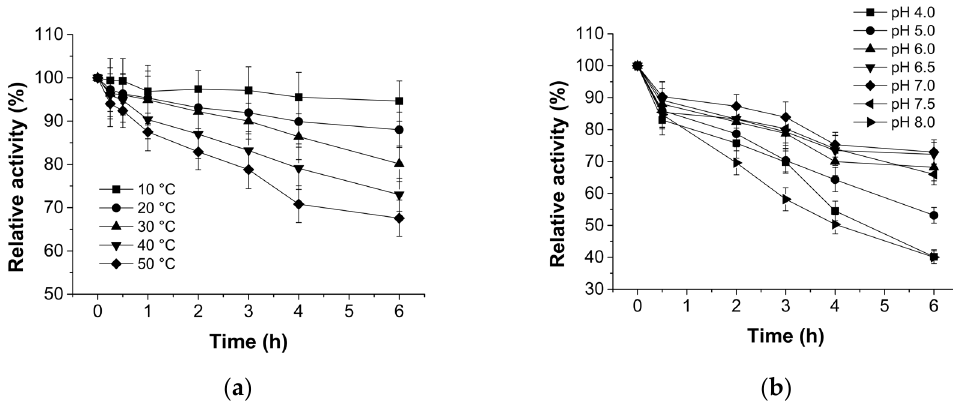
Figure 4. ( a ) The thermal stability of recombinant NHase. ( b ) The pH stability of recombinant NHase. The specific activity of purified enzyme equal to 100% was 3.18 U mg − 1 protein. Table 1. The organic solvent tolerance of recombinant NHase. Organic Solvent